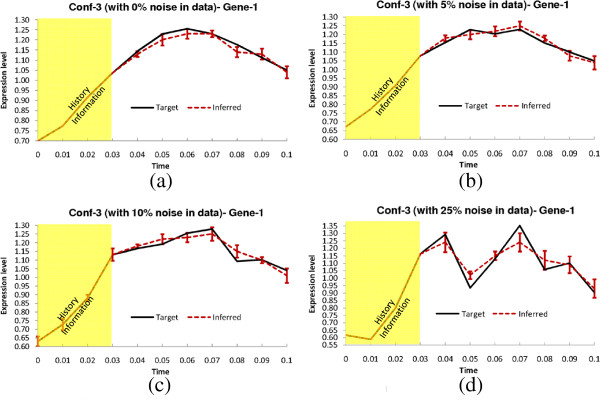
Dynamics for Gene-1 of Conf-3. Solid lines and dotted lines indicate respectively target and inferred (by TDSS) time-expressions in (a) Noise free data (b) 5% Noise in data (c) 10% Noise in data (d)25% Noise in data. The yellow shaded region indicates the history information and the error bars indicate 95% confidence interval.